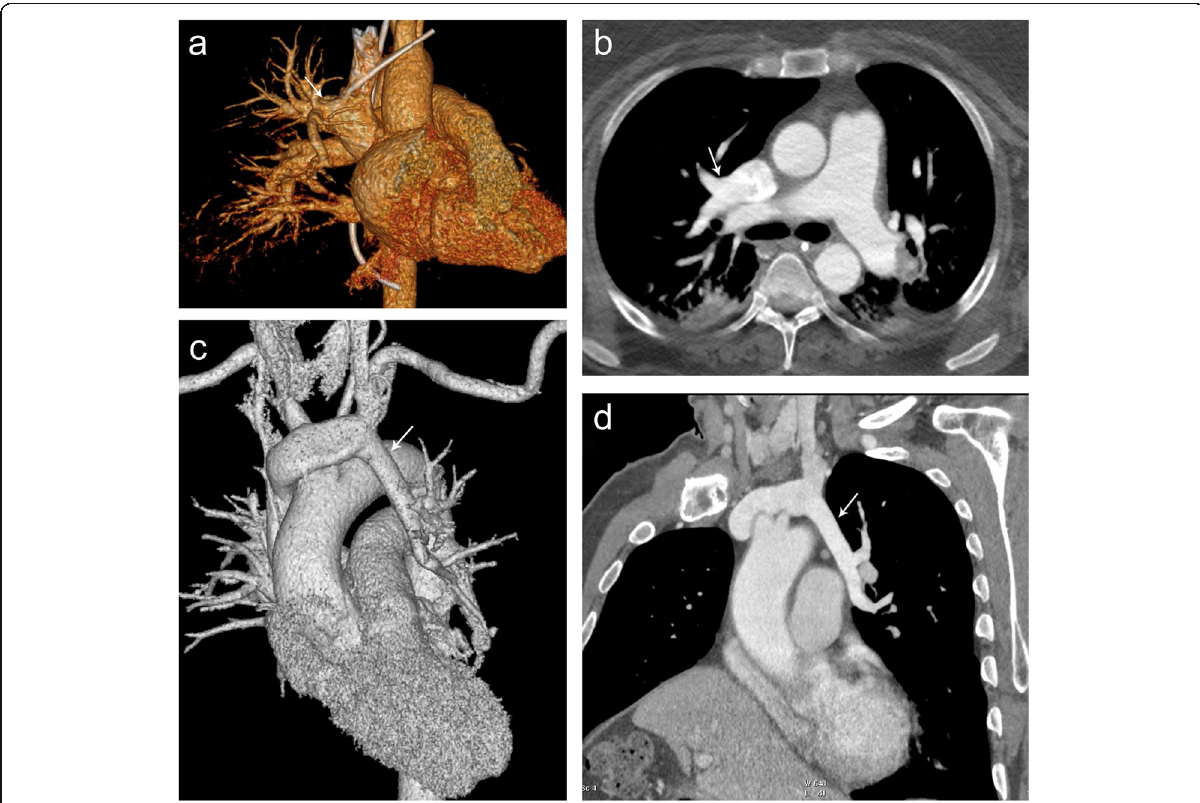
Fig. 6 Partial anomalous pulmonary venous return. 3D reformat ( a ) and axial contrast-enhanced CT ( b ) demonstrating right upper lobe partial anomalous pulmonary venous return (arrow) draining into the SVC. 3D reformat ( c ) and double oblique ( d ) contrast-enhanced CT demonstrating left upper lobe partial anomalous pulmonary venous return (arrow) draining to the left brachiocephalic